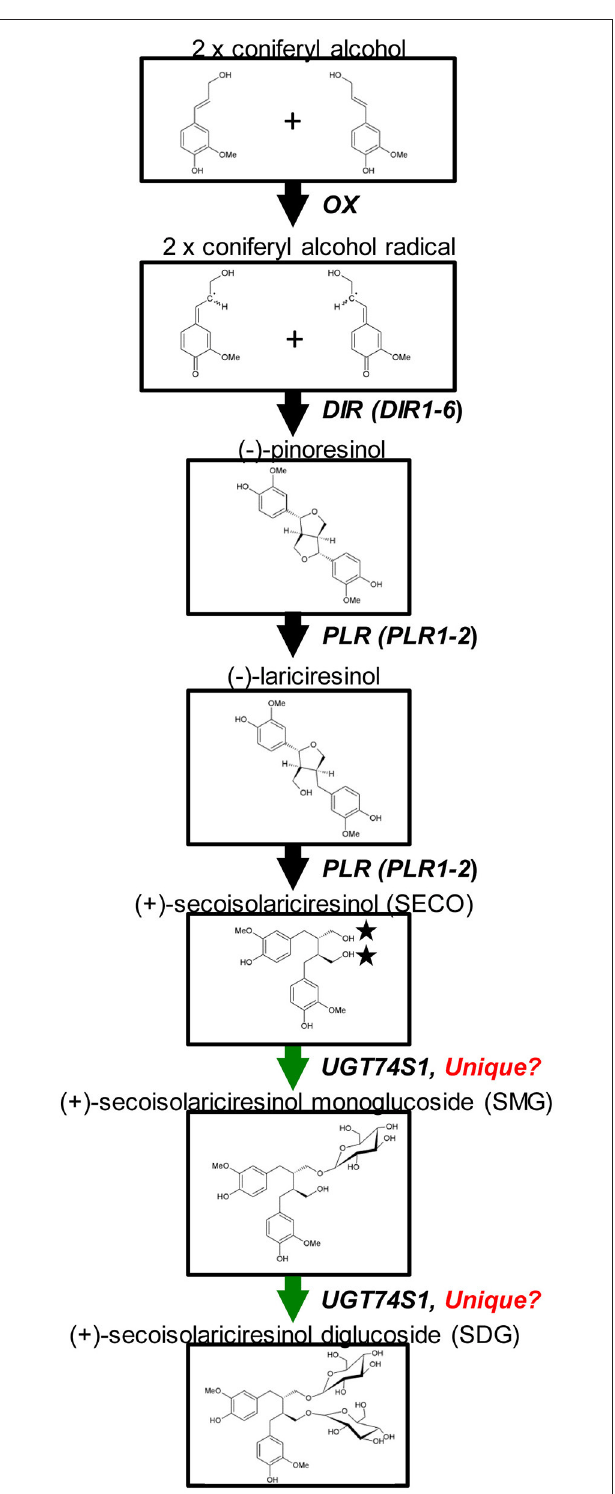
FIGURE 1 | Current knowledge of flax lignan biosynthetic pathways. Genes with known functions are shown (adapted from Kim et al., 2009) with the permission of Dr. Honoo Satake and PCP editorial office and from Ghose et al. (2014) with the permission of BMC Plant Biology editorial